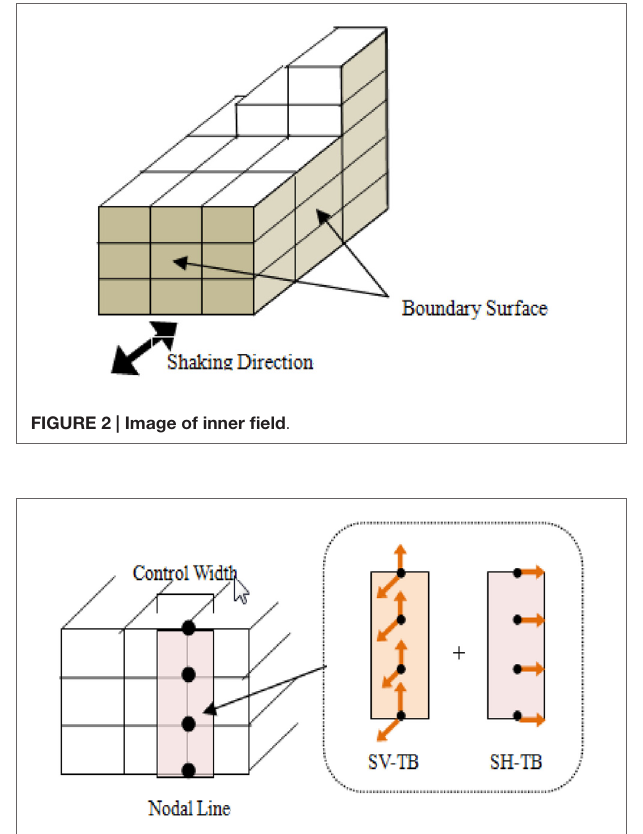
FigUre 3 | assignments of sV-TB and sh-TB to nodal line .